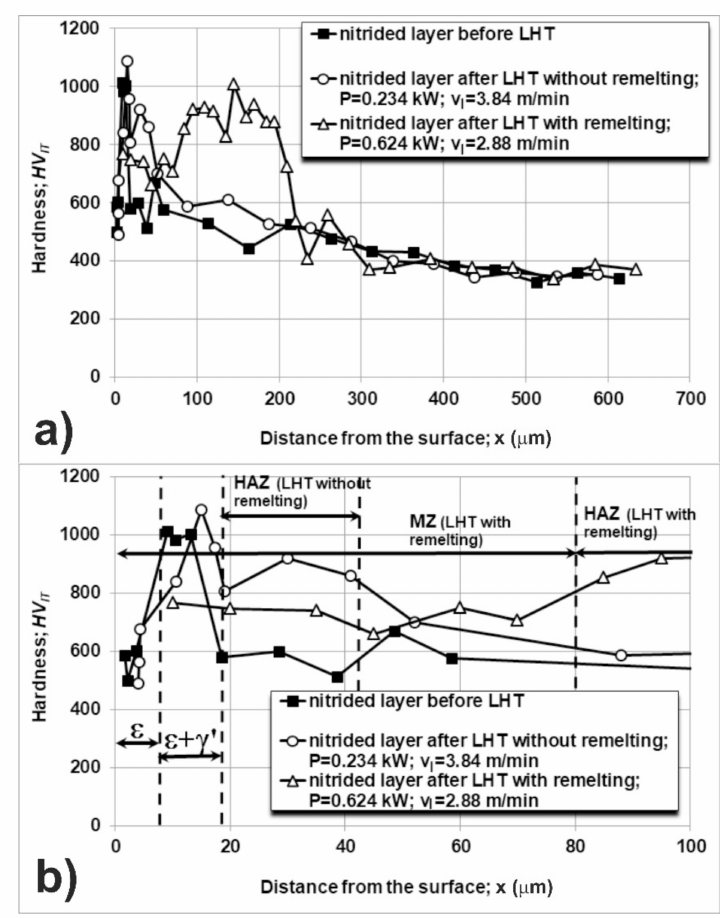
Figure 15. Profiles of Vickers hardness HV IT in the selected single laser tracks after LHT of gas-nitrided layer with or without remelting compared to the gas-nitrided layer: HV IT profiles in the entire layers ( a ); HV IT profiles close to the surface ( b